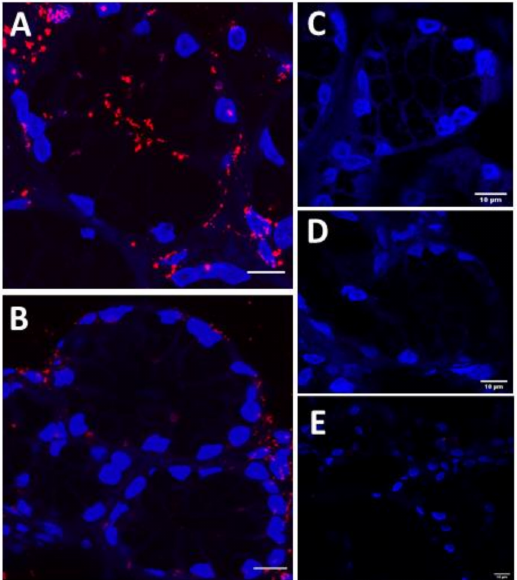
Figure A2. Protein–protein interactions visualized as red fluorescent spots in hMSG from SICCA-NS ( A ) and SICCA-SS ( B ). Negative controls were performed using hMSG from SICCA-NS in the absence of anti-AQP5 antibody ( C ), anti-Ezrin ( D ), or both primary antibodies ( E ). Scale bar, 10 µ